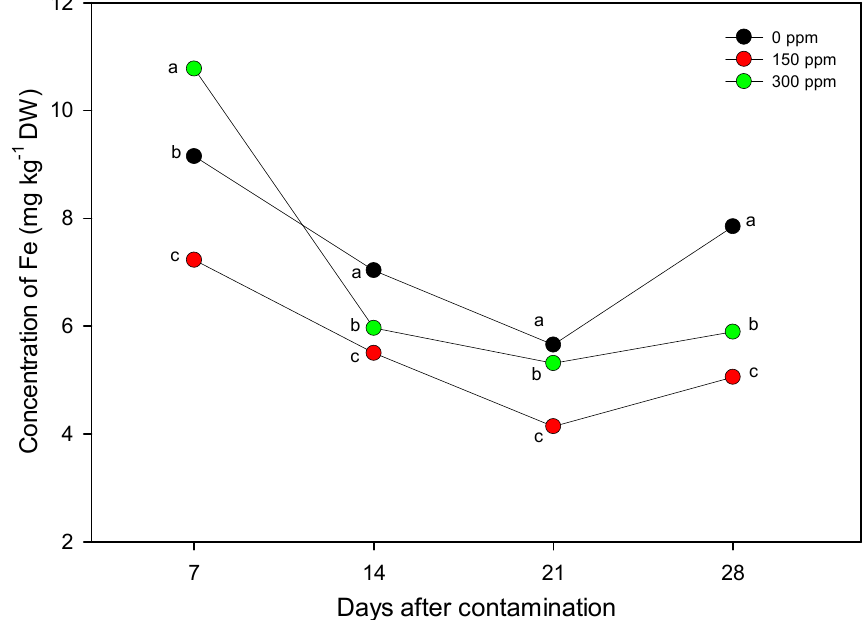
Figure 7. Time course of the iron concentration in the leaves of Arundo plants treated with different copper concentrations (0, 150, and 300 ppm) for 28 days. Data points and vertical bars represent means (n = 3) ± S.E., respectively (when not reported S.E. is smaller than symbol size). One-way ANOVA was applied and for a given duration different letters indicate significant difference according to Tukey test ( p ≤ 0.01).